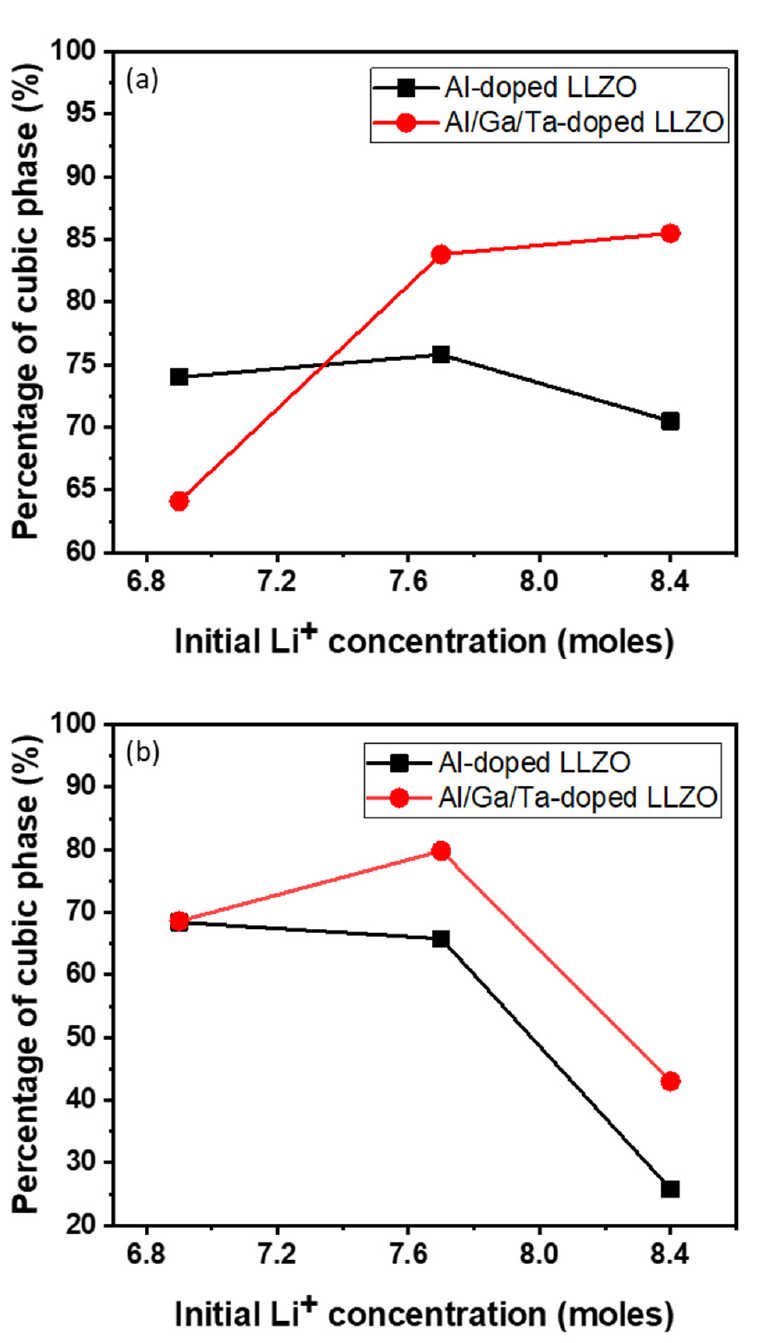
Figure 3. Relative weight fraction of cubic phase of ( a ) doped powders and ( b ) doped pellets by the XRD Rietveld refinement.